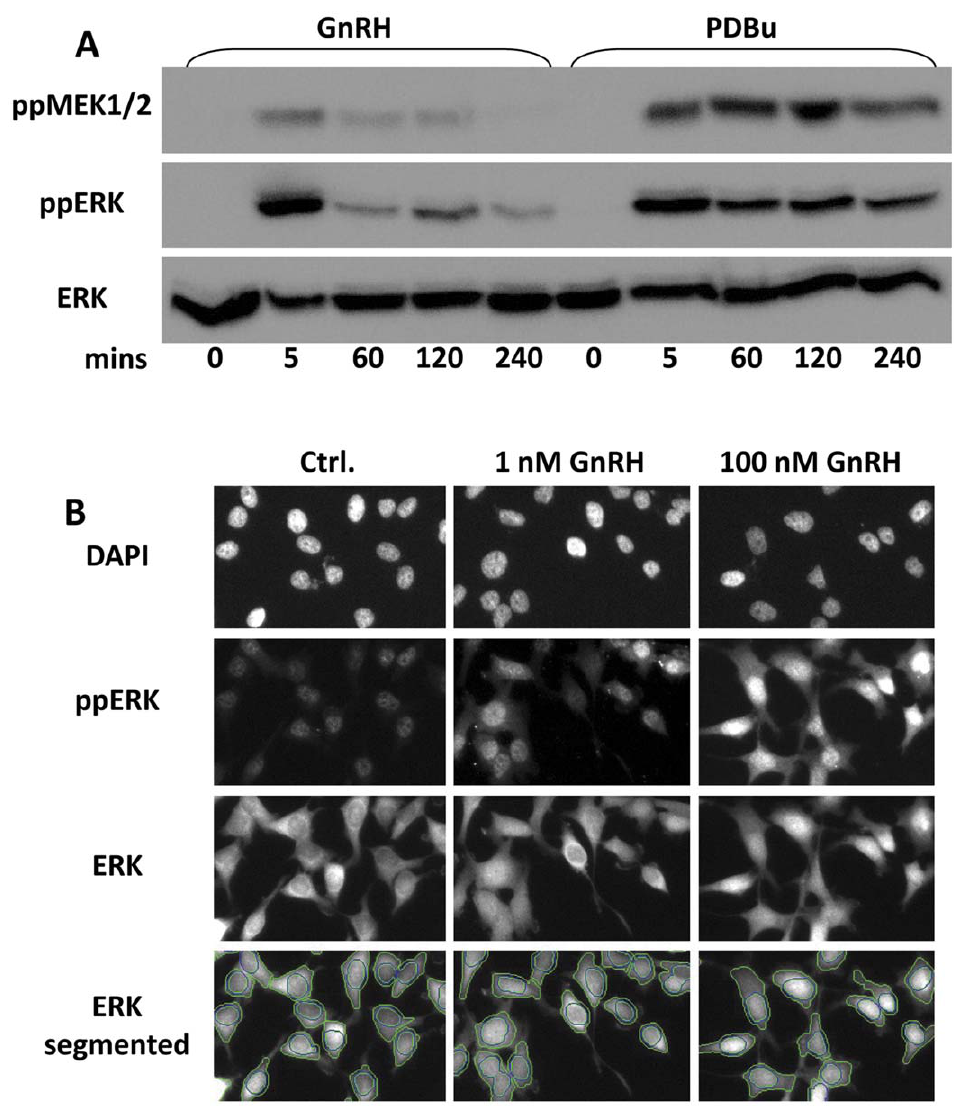
Figure 1. GnRH-stimulated MEK-ERK measured by western blotting or high content imaging. (A) HeLa cells were seeded in 12 well plates, transduced with Ad mGnRHR and kept in reduced (0.1%) serum for 16 hours prior to stimulation for varied periods with 100 nM GnRH or 1 m M PDBu. Whole cell protein extracts were then immunoblotted for phospho Ser217/221 MEK1/2 (ppMEK1/2), phospho Thr183/Tyr185 ERK (ppERK) and for total ERK (ERK1 and/or 2) as indicated. (B) HeLa cells were seeded in 96-well imaging plates, transduced with Ad mGnRHR and kept in reduced (0.1%) serum for 16 hours prior to stimulation for 5 min with 1 or 100 nM GnRH as indicated. Control cells (Ctrl.) were treated with medium alone. The cells were then fixed and stained for endogenous ppERK, ERK and DAPI before image acquisition and analysis (as described in the Methods). The figure shows representative images and the lower images show ‘‘segmented’’ ERK staining, with lines indicating the perimeters of the nuclei and cells obtained using automated image analysis algorithms, as described in the Methods. Each of the image panels corresponds to a width of approximately 250 m m and represents approximately 1/20 th of the area captured in each field of view. doi:10.1371/journal.pone.0040077.g001 treated for 5 min with 100 nM GnRH a different relationship was observed with the N:C ERK ratio increasing to a maximum of approximately 2.2. Importantly, ERK N:C levels were greater than that of control cells in almost all comparable ppERK bins (Fig. 3B, left panel). A similar uncoupling of responses was seen in cells stimulated for 5 min with 1 nM GnRH (not shown), and when a single bin size (ppERK 240 to 320 AFU) was used to monitor whole cell ppERK levels in cells stimulated for 5 min with varied doses of GnRH (Fig. 3B, right panel). Using the same approach to establish the time-course of GnRH effects, we